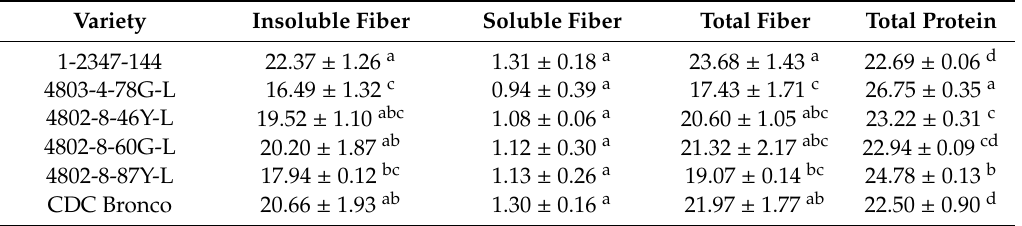
Table 3. Protein and fiber concentrations (g / 100 g) of tested peas varieties 1 .